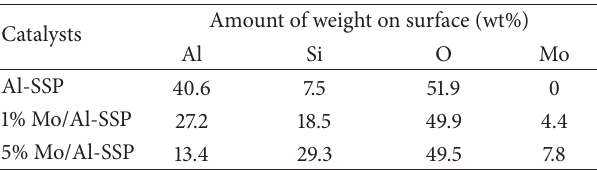
Table 2: The amount of each element near the surface of catalyst granule obtained from EDX.